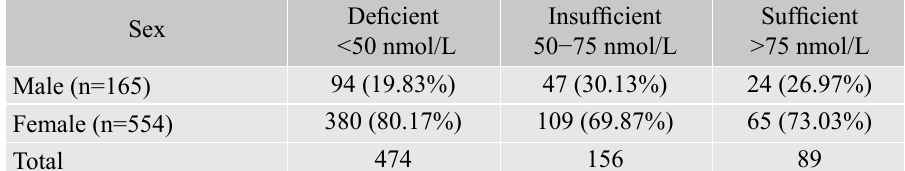
Table IV: Distribution of vitamin D status in subjects from 21−40 years (n=719)